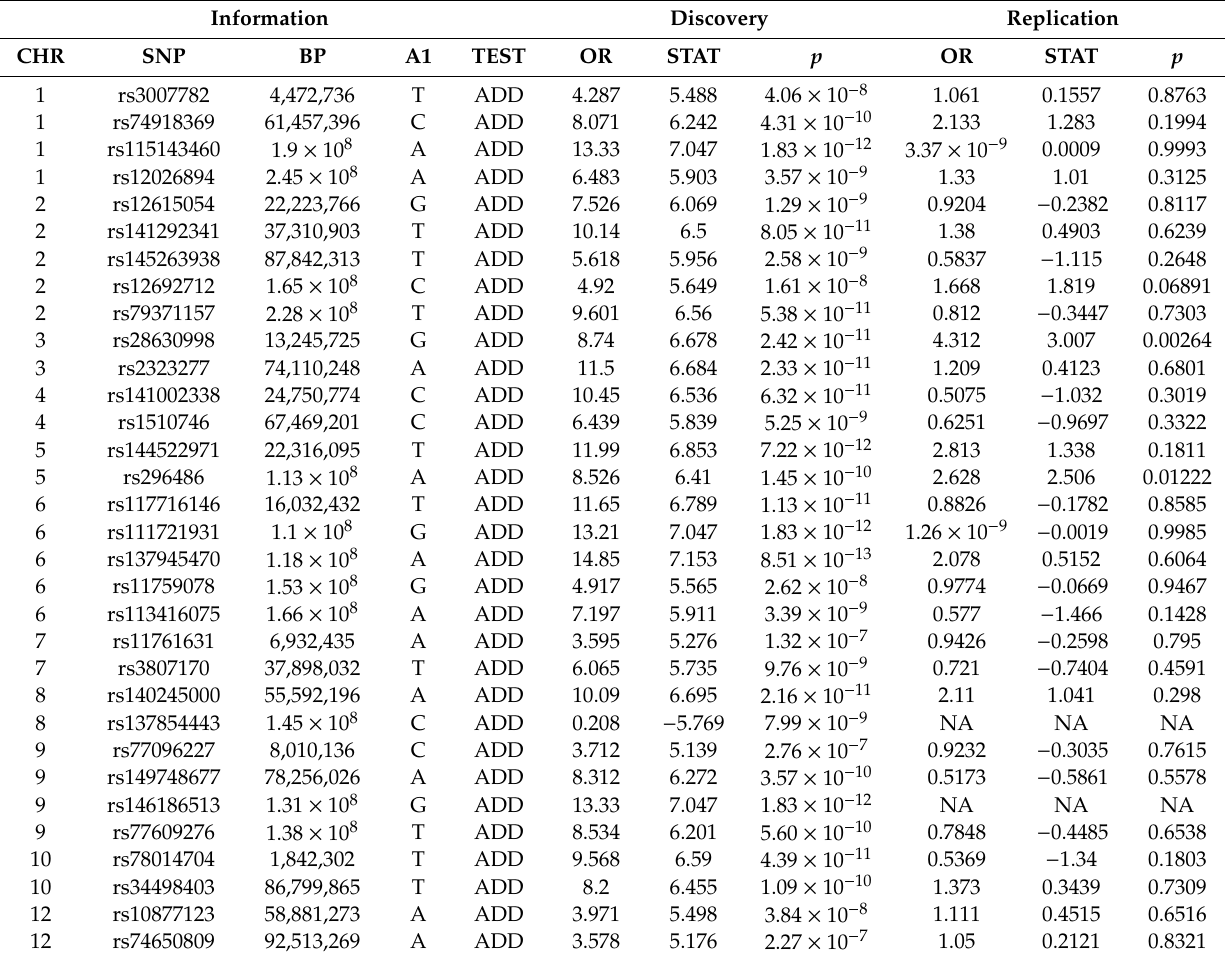
Table 1. The statistical results of additive model logistic regression analysis in the discovery and replication sets. CHR, chromosome. SNP, single nucleotide polymorphism. BP, physical position. A1, minor allele. TEST, logistic regression test method for the genetic model. OR, odds ratio. STAT, Coe ffi cient t -statistic. P, p